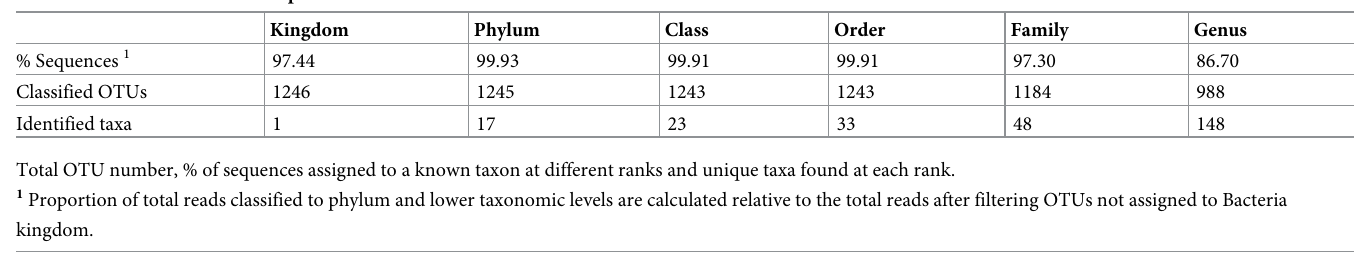
Table 2. Overall microbiota composition.